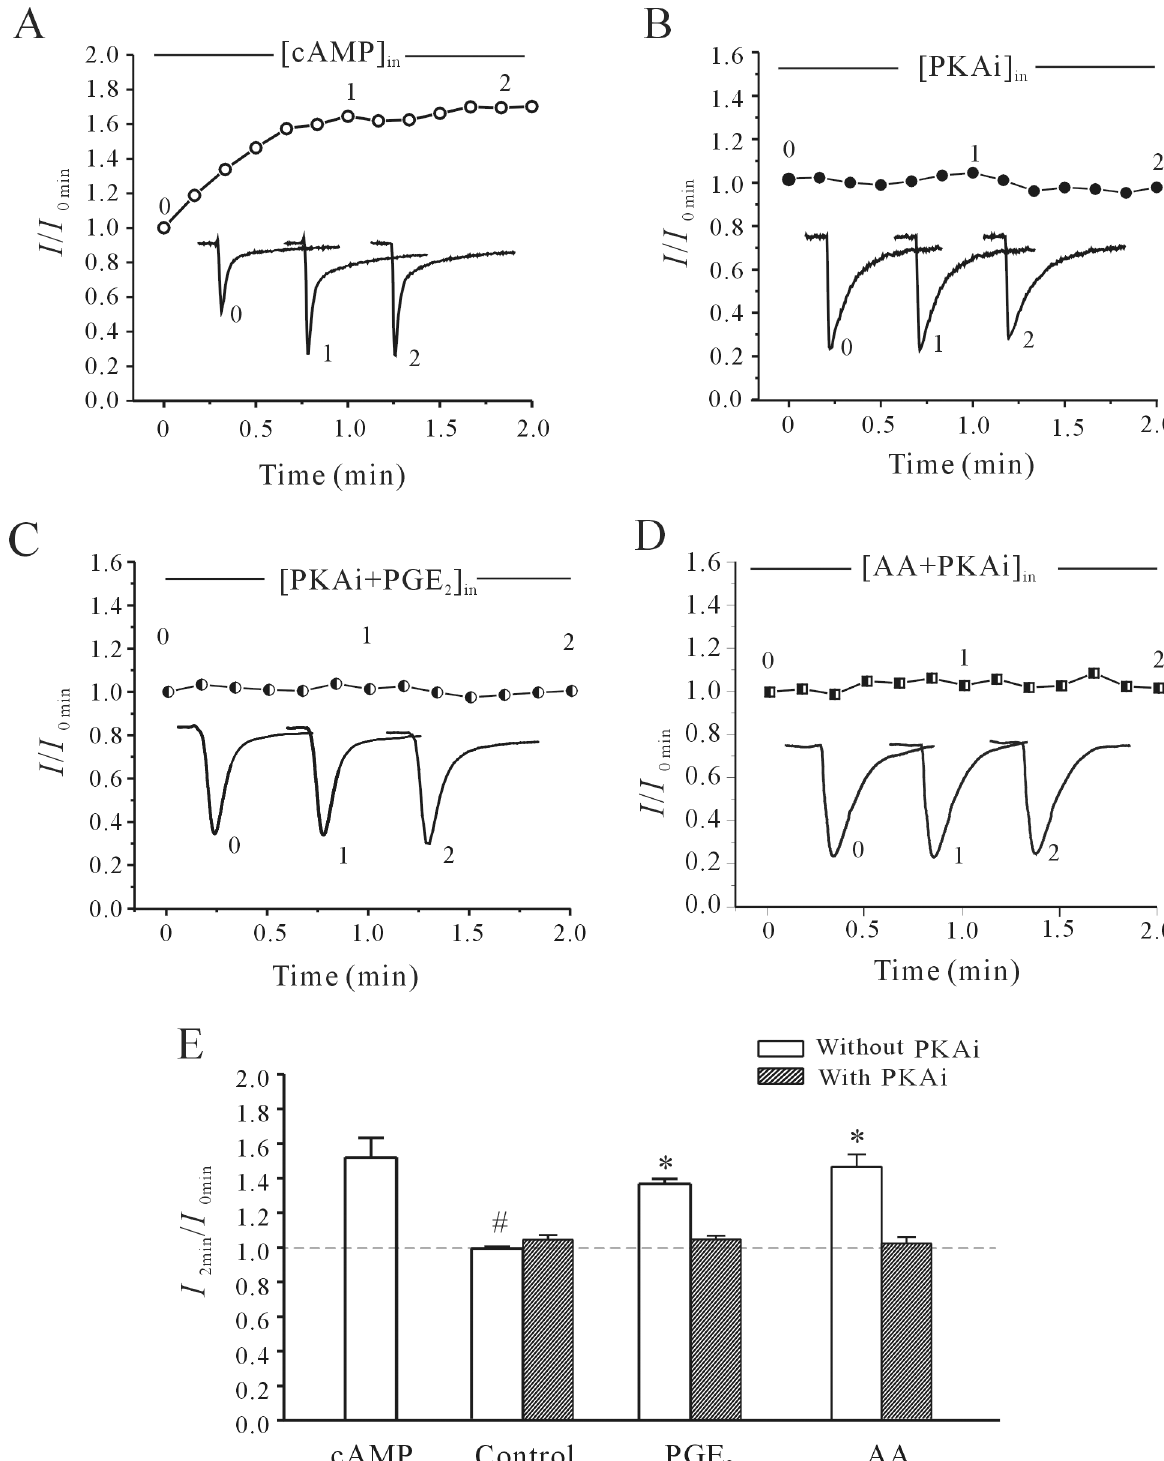
Fig 8. Effect of activating or blocking cAMP/PKA pathways on AA/PGE 2 -induced increases in rNa V 1.4 current. (A) Time course of changes in rNa V 1.4 current amplitudes induced by intracellular application of 10 μ M db-cAMP. (B) Time course of changes in rNa V 1.4 current amplitudes induced by 50 nM PKAi. (C and D) Time course of changes in rNa V 1.4 current amplitudes induced by 10 μ M PGE 2 or 10 μ M AA in the presence of PKAi. The time points (0 min, 1 min and 2 min) noted on the curves correspond to the superimposed rNa V 1.4 current traces in the insets. (E) Statistical analysis of the effects of cAMP or